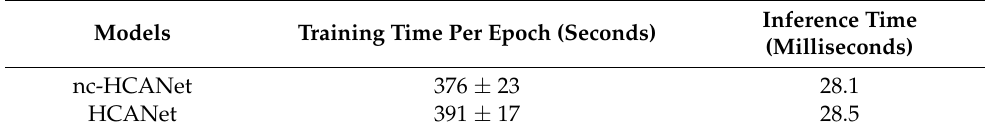
Table 6. Efficiency